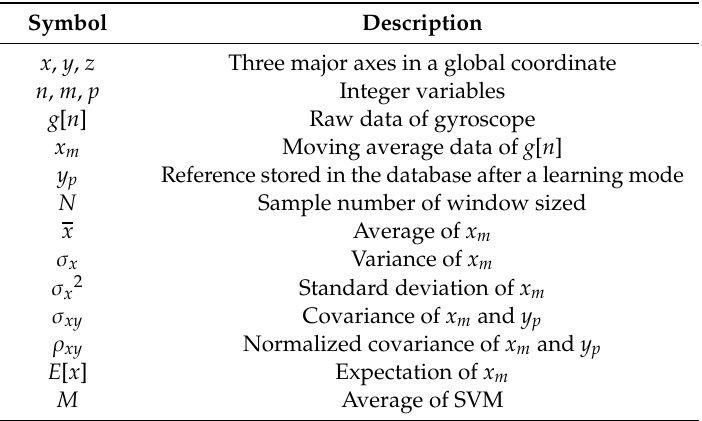
Table 2. Notation in this